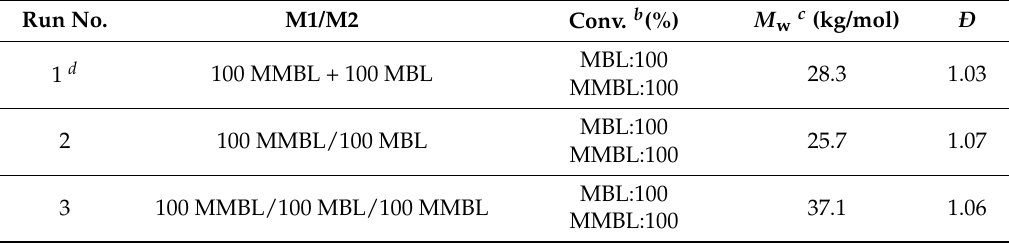
Table 2. B(C 6 F 5 ) 3 -catalyzed copolymerization of MMBL and MBL by i Bu SKA/B(C 6 F 5 ) 3 system a . Run